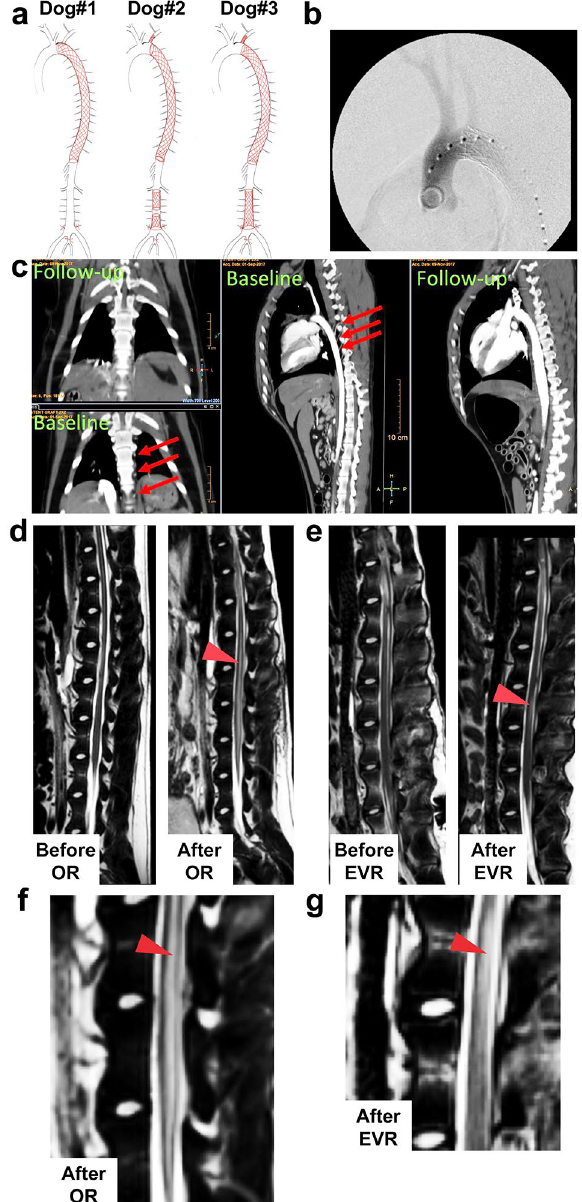
showing frontal (two left panels) and lateral (two right panels) views of EVR dog#3 before (baseline) and after (day 2) occlusion following EVR. Arrows point at segmental arteries before aortic stenting. ( d ) Sagittal T2-weighted MRI images: left, before OR surgery, showing no signal; right, after OR, showing abnormal signal centrally within the cord involving grey matter (arrowhead). ( e ) Sagittal T2-weighted MRI images of EVR dog#3: left, before EVR surgery, showing no signal; right, after EVR, showing abnormal signal within the posterior aspect of the cord at L3 involving white matter (arrowhead). ( f ), ( g ) Enlargements from right panels in ( d ) and ( e ),